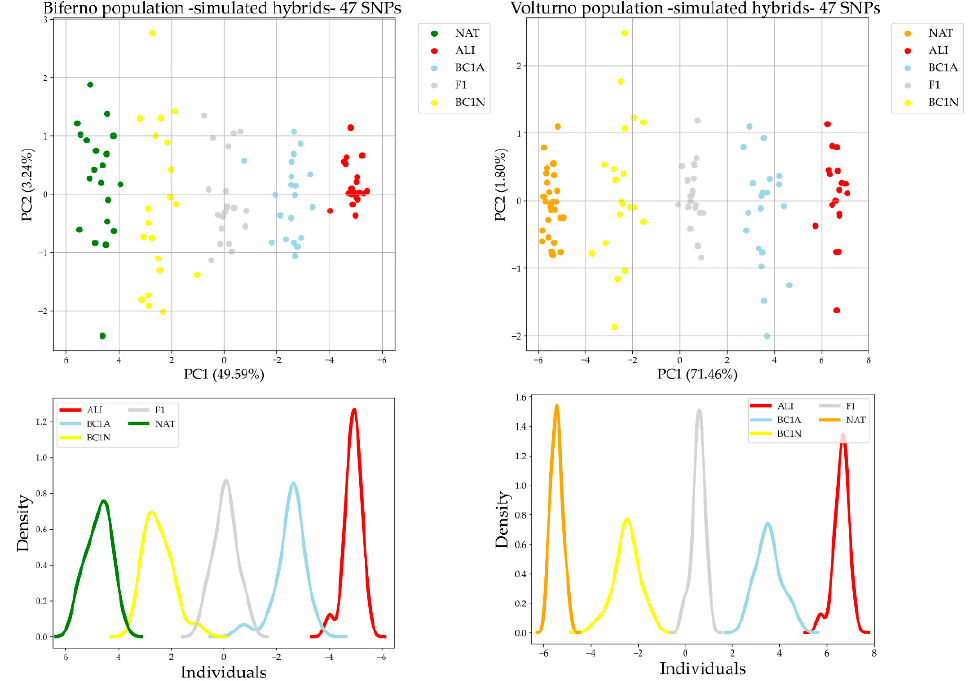
Figure 3. PCA and density distribution of the PC1 obtained using the common 47 AIMs on reference populations and simulated hybrid dataset split by rivers.